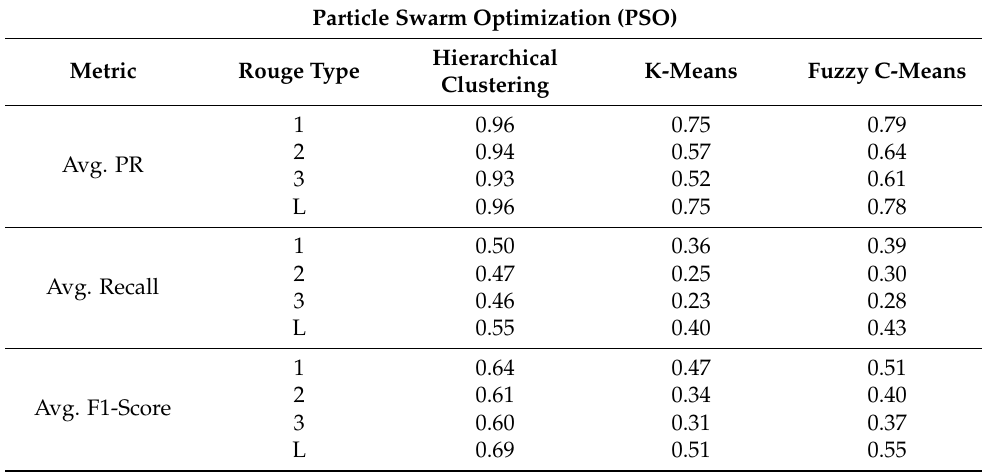
Table 2. Particle Swarm Optimization (PSO) with clustering